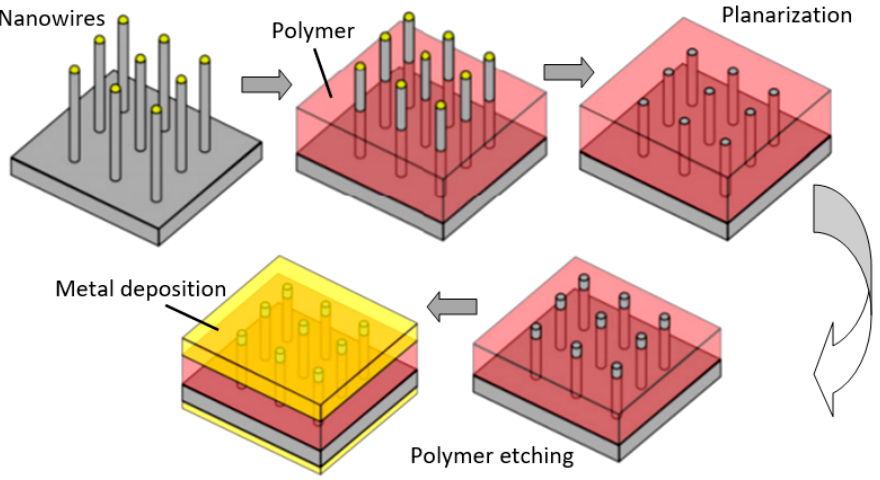
Figure 27. Schematic illustration of the contact forming on the top of vertically grown NWs.